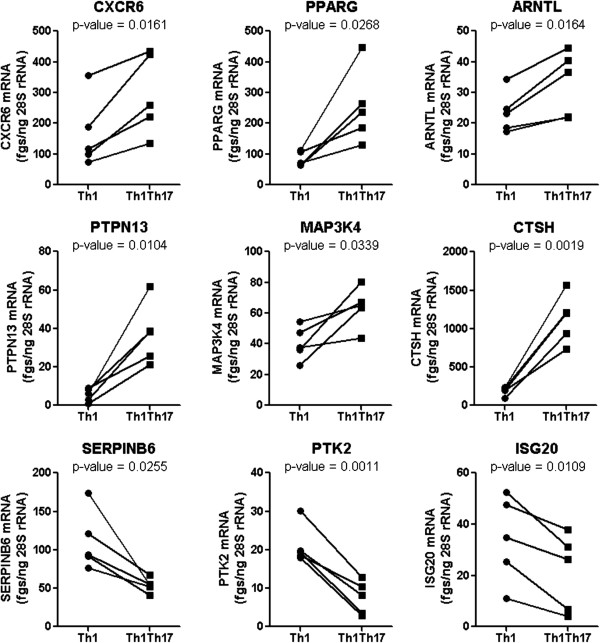
RT-PCR validation of differentially expressed genes. Total RNA was extracted from CD3/CD28-stimulated matched Th1Th17 and Th1 subsets. The expression of CXCR6, PPARγ, ARNTL, PTPN13, MAP3K4, CTSH, SERPINB6, PTK2, and ISG20 mRNA was quantified by SYBR green real time RT-PCR. Quantification was performed relative to a standard curve generated based on cDNA specific for each transcript. The expression of each gene was normalized to the 28S rRNA internal control and expressed as fgs RNA of a target gene per 1 ng 28S rRNA. Depicted are results obtained with matched Th1Th17 vs. Th1 cells from five different HIV-uninfected individuals. Paired t-Test values are indicated on the graphs.